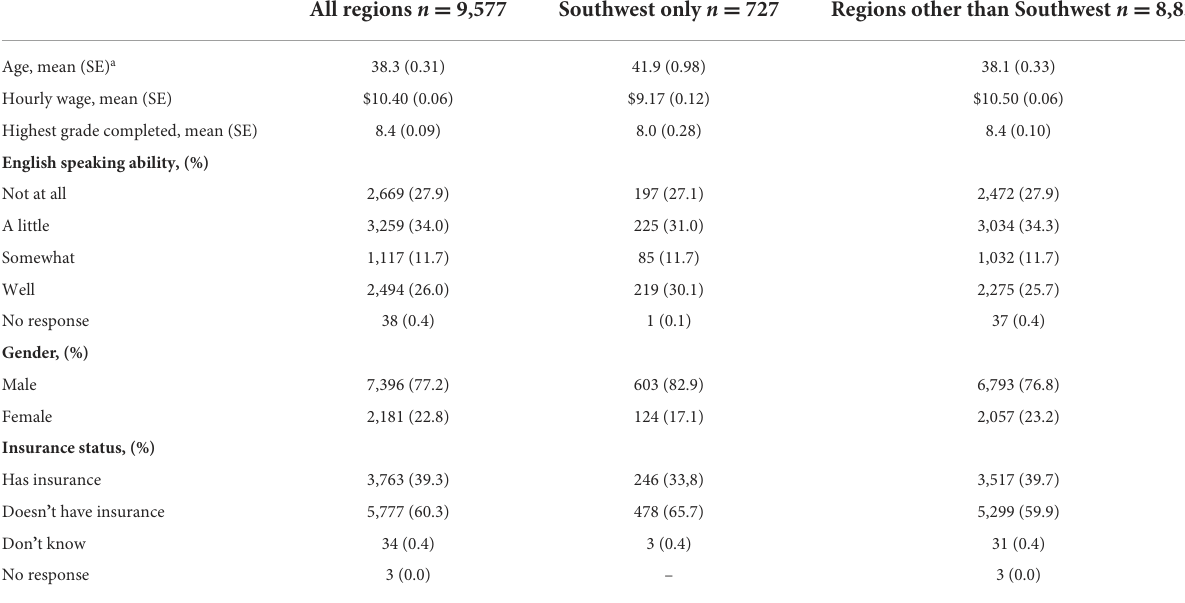
TABLE 1 Demographic characteristics of farmworkers interviewed in NAWS, Southwest compared to other regions 2013–2016.